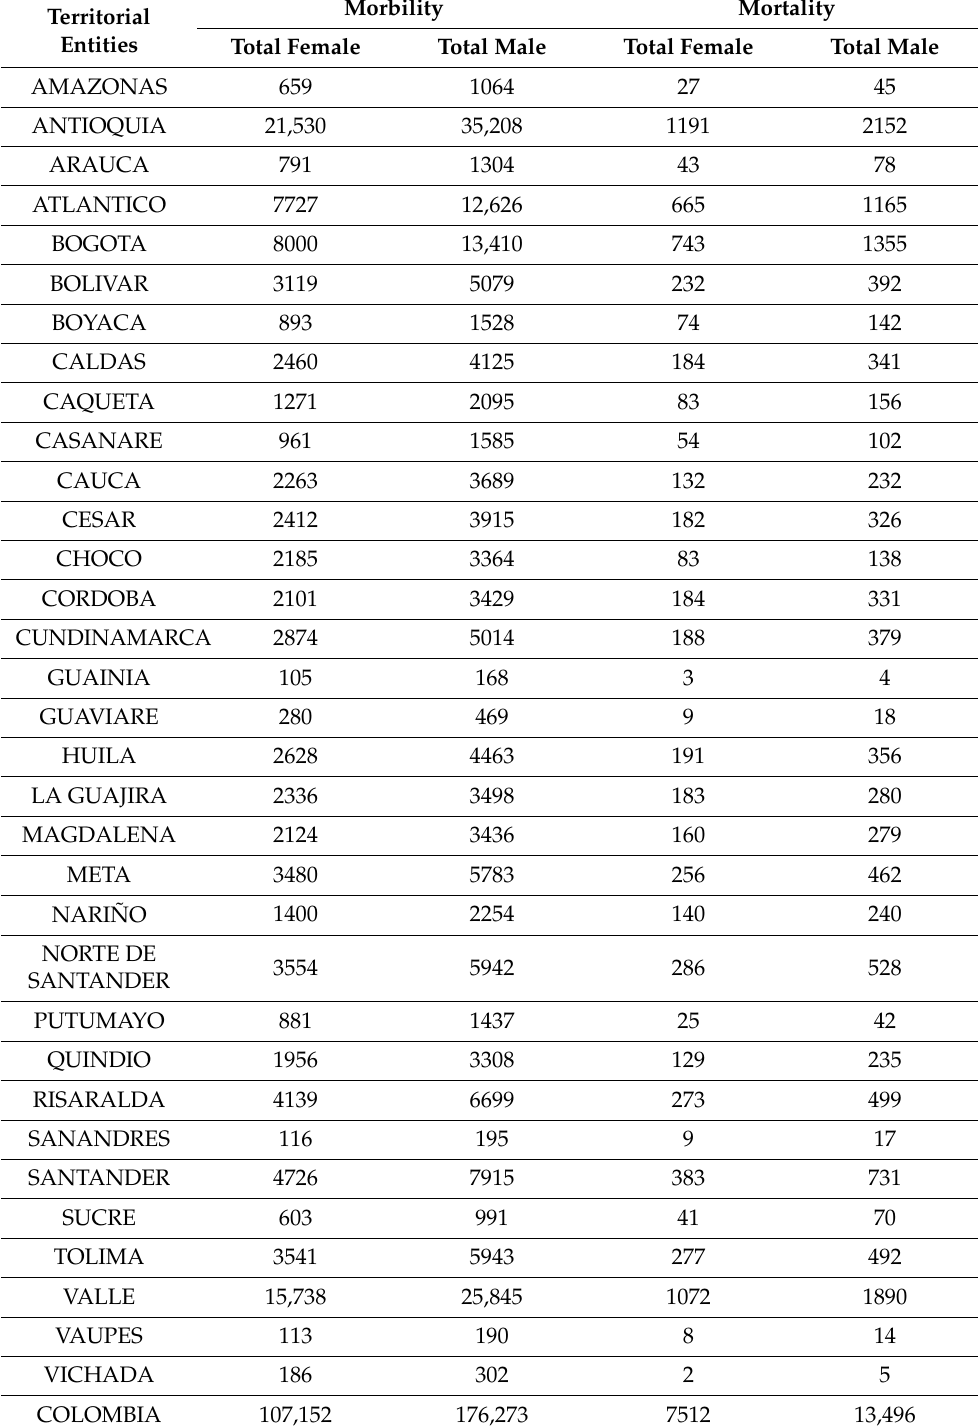
Table 1. Tuberculosis mortality and mobility by sex and territorial entities, Colombia,